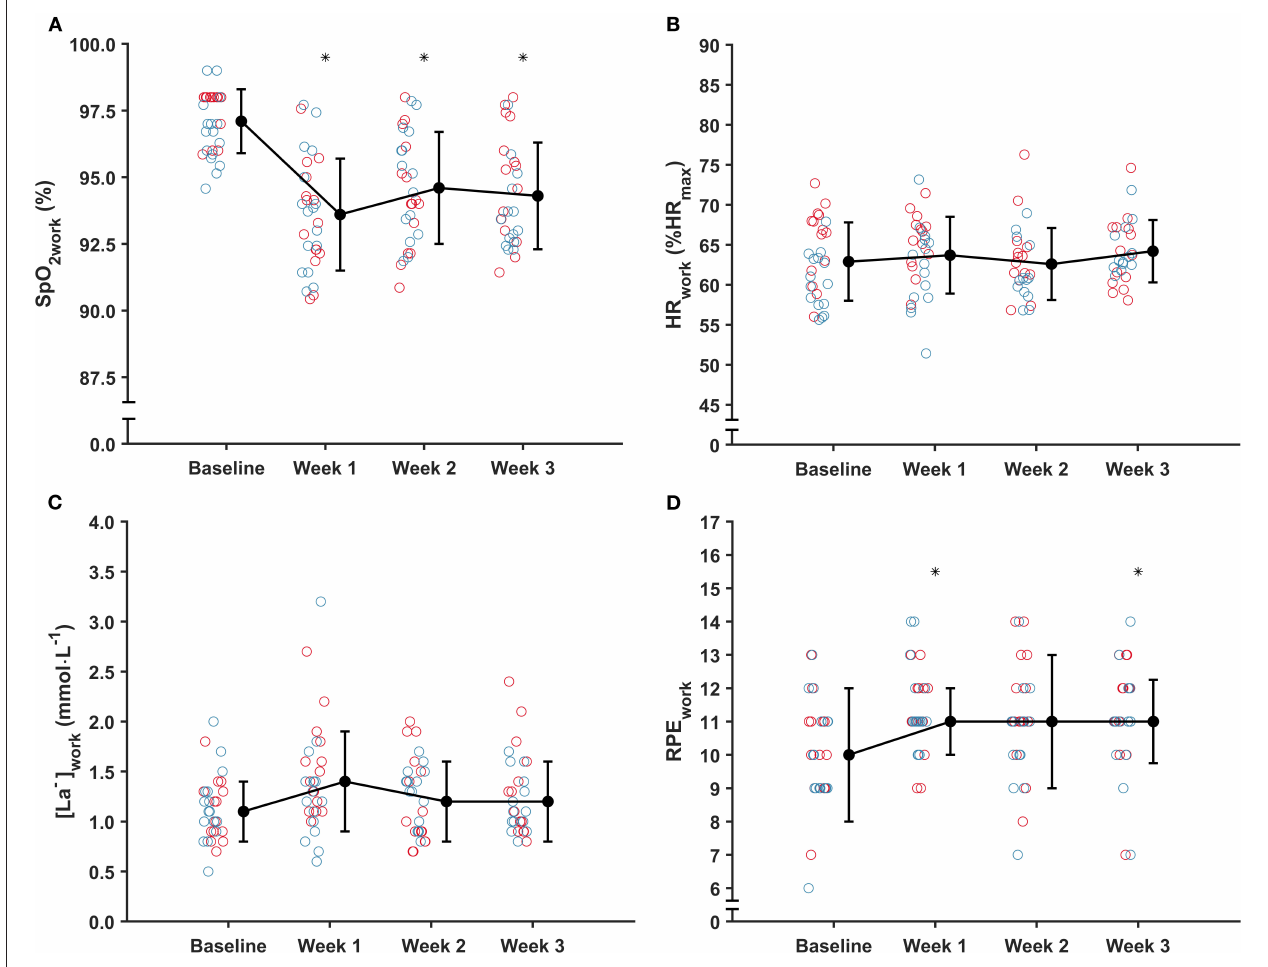
FIGURE 4 | Mean ± SD (A) arterial oxygen saturation (SpO 2work ); (B) relative heart rate (HR work ); (C) blood lactate concentration [La − ] work ; and median ± IQR (D) rating of perceived exertion (RPE work ) during the 5-min submaximal cycling test at baseline (i.e., near sea level) and on three weekly occasions during the training camp (i.e., at 1,800m). Red circles, women; blue circles, men. *Significantly different from baseline ( p < 0.05).